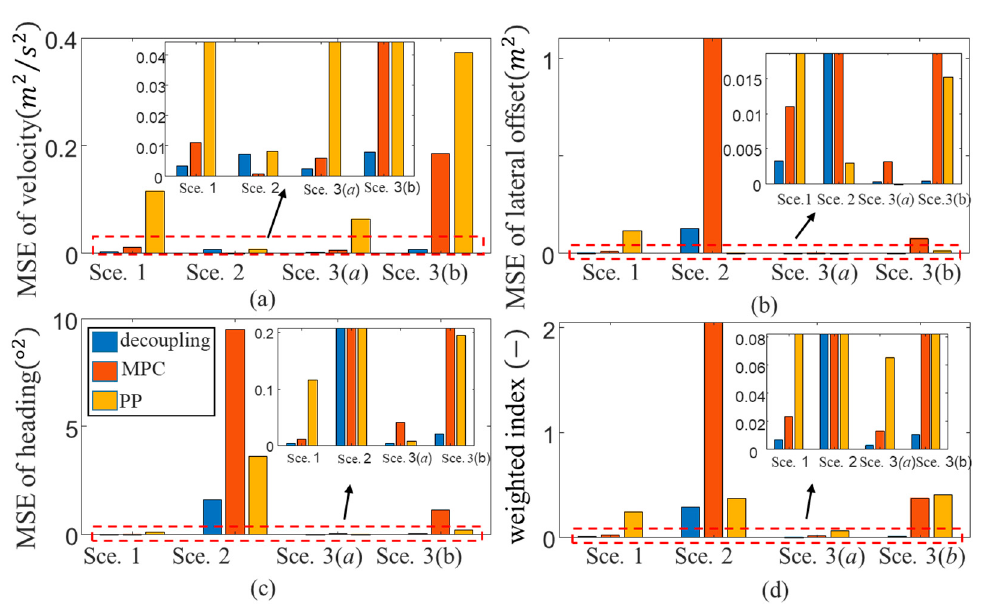
Figure 12. The tracking performance index: ( a ) the longitudinal direction; ( b ) the lateral direction; ( c ) the yaw direction; ( d ) the planar motion.